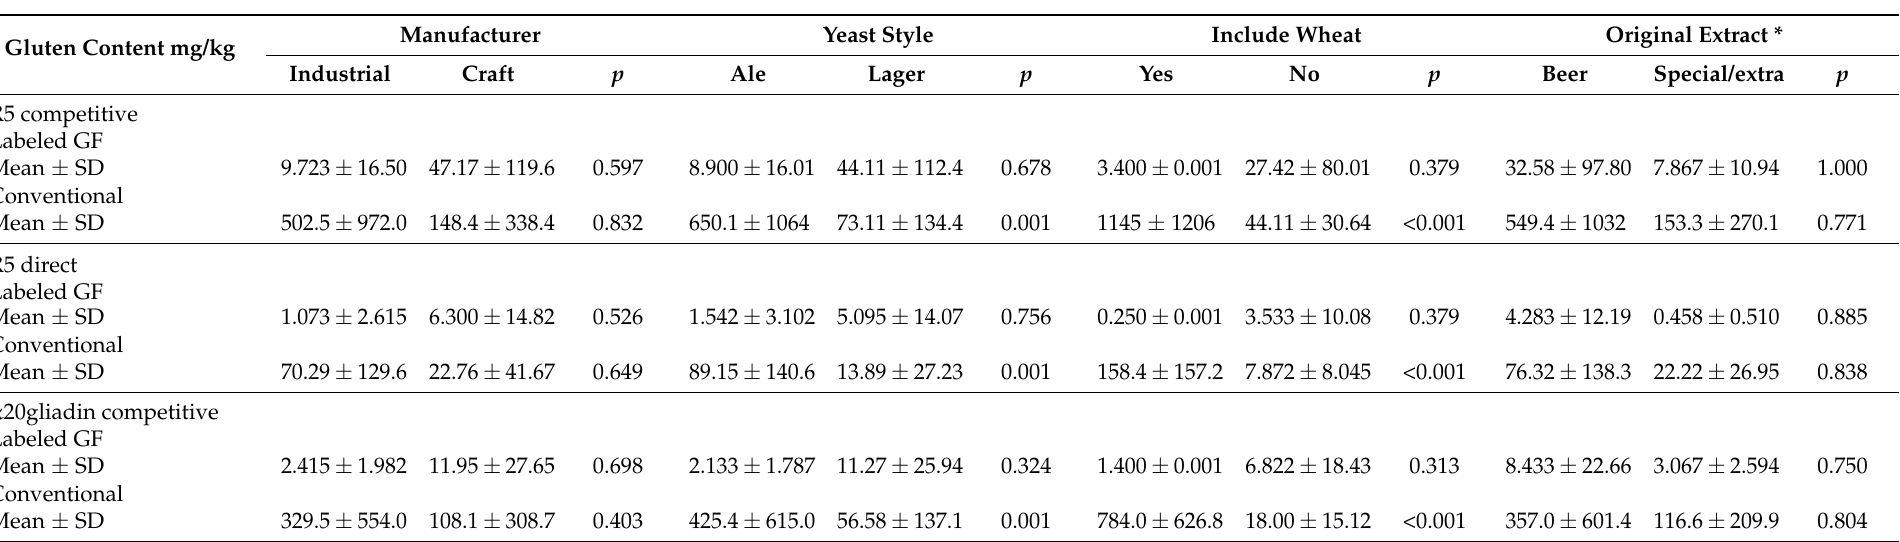
Table 3. Comparison of the three enzyme-linked immunosorbent assays gluten results in beer ´ s cohort by different classification